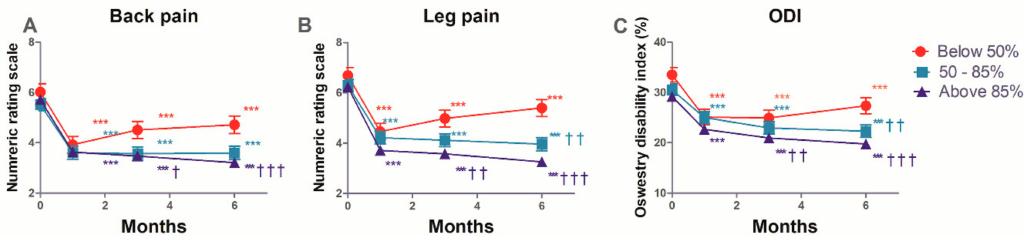
Figure 3. Numerical rating scale (NRS) of back ( A ) and leg ( B ) pain, and Oswestry disability index (ODI; ( C )) at baseline (0), and at 1, 3, and 6 months after epidural decompression and adhesiolysis with a balloon-inflatable catheter. The patients were divided into groups of less than 50%, 50–85%, and 85% success rate depending on the rate of successful ballooning procedures per target site. ** p < 0.01 vs. baseline. *** p < 0.001 vs. baseline. † p < 0.05 compared with the below 50% group at each time point. †† p < 0.01 compared with the below 50% group at each time point. ††† p < 0.001 compared with the below 50% group at each time point. The data are presented as estimated mean ± 95% confidence